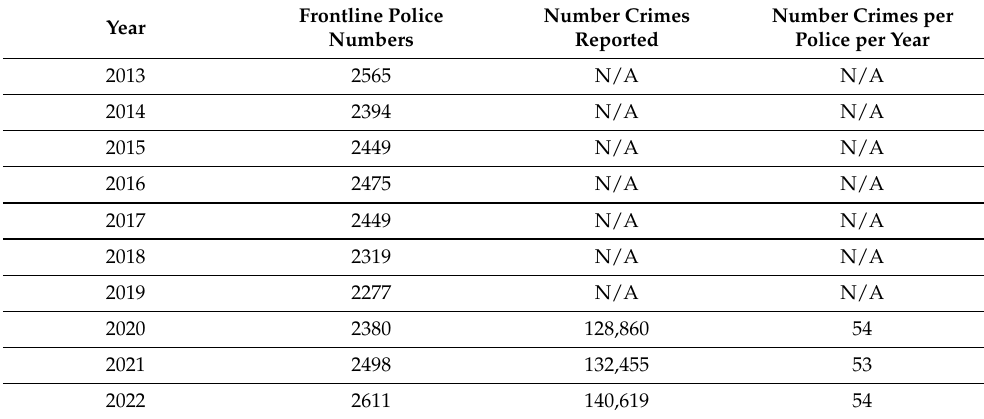
Table 2. Data since 2010 on number of frontline police in Avon and Somerset together with the number of crimes reported for the 3 years 2020–2022 inclusive. Police numbers were obtained from the annual reporting tool for the UK government [38] and crimes with police incident numbers by the local police force